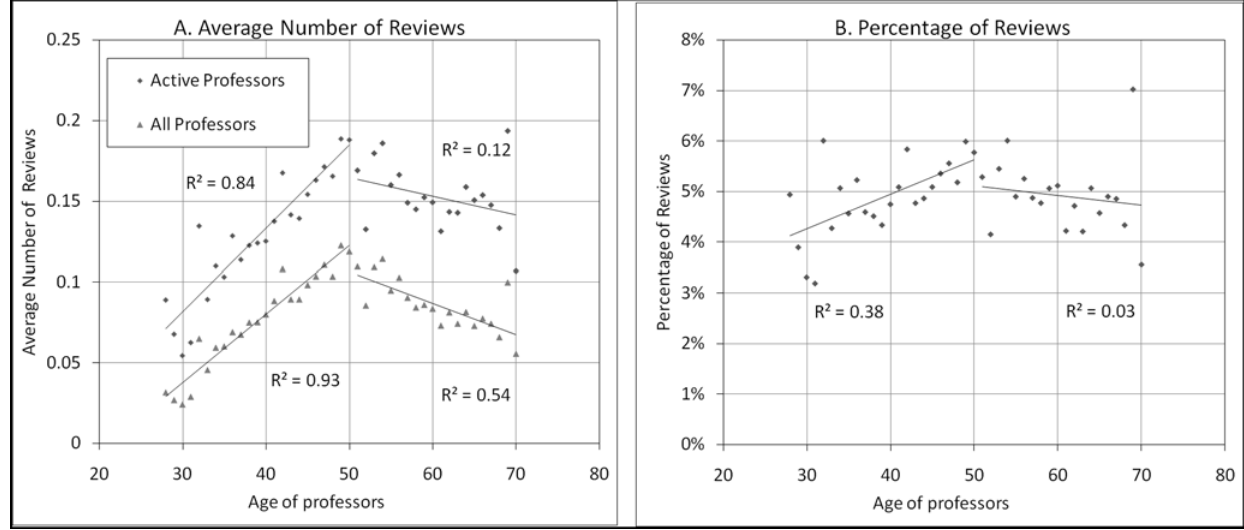
Figure 6. Distribution of review articles by professor age A) Average number of reviews (active professors) B) Percentage of reviews.